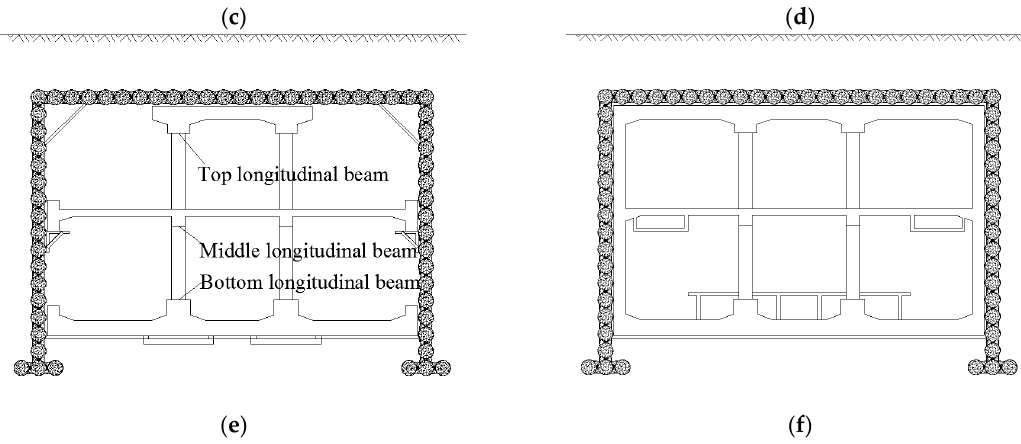
Figure 6. Construction stages in the new support system. Note: Z1, Z2, Z3 and Z4 represent pilot tunnel; C1 and C2 represent cylindrical steel column.